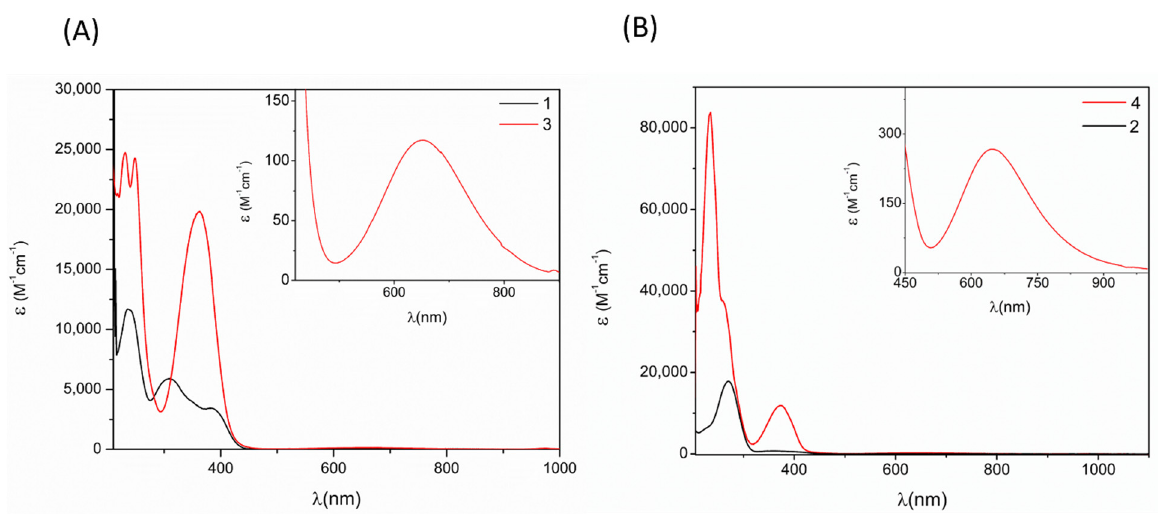
Figure 5. UV-Vis spectra of 1 and 3 ( A ), and 2 and 4 ( B ). Table 4. Electronic spectral data (nm) of the ligands and their complexes.